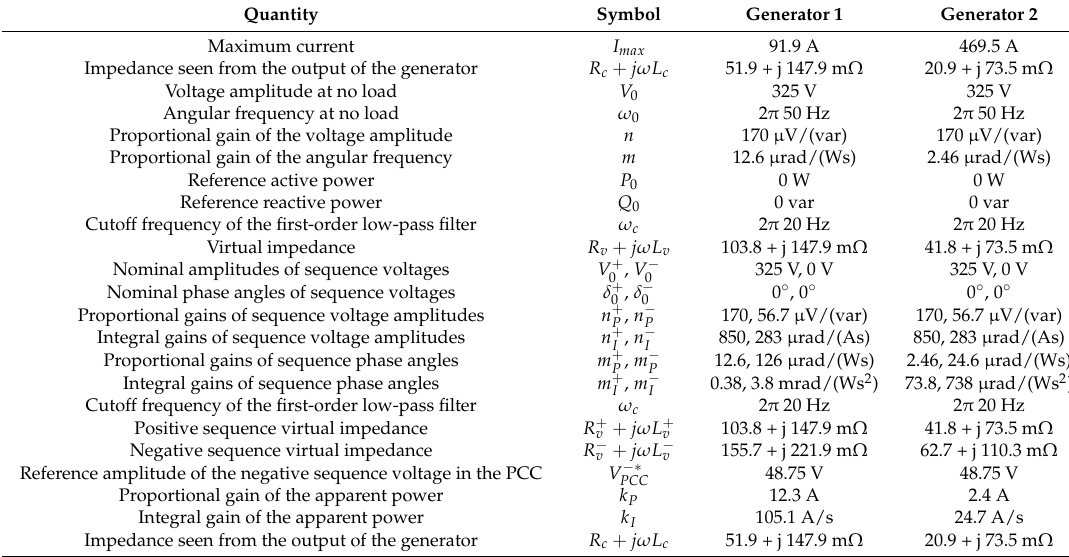
Table 2. Parameters of the control schemes.